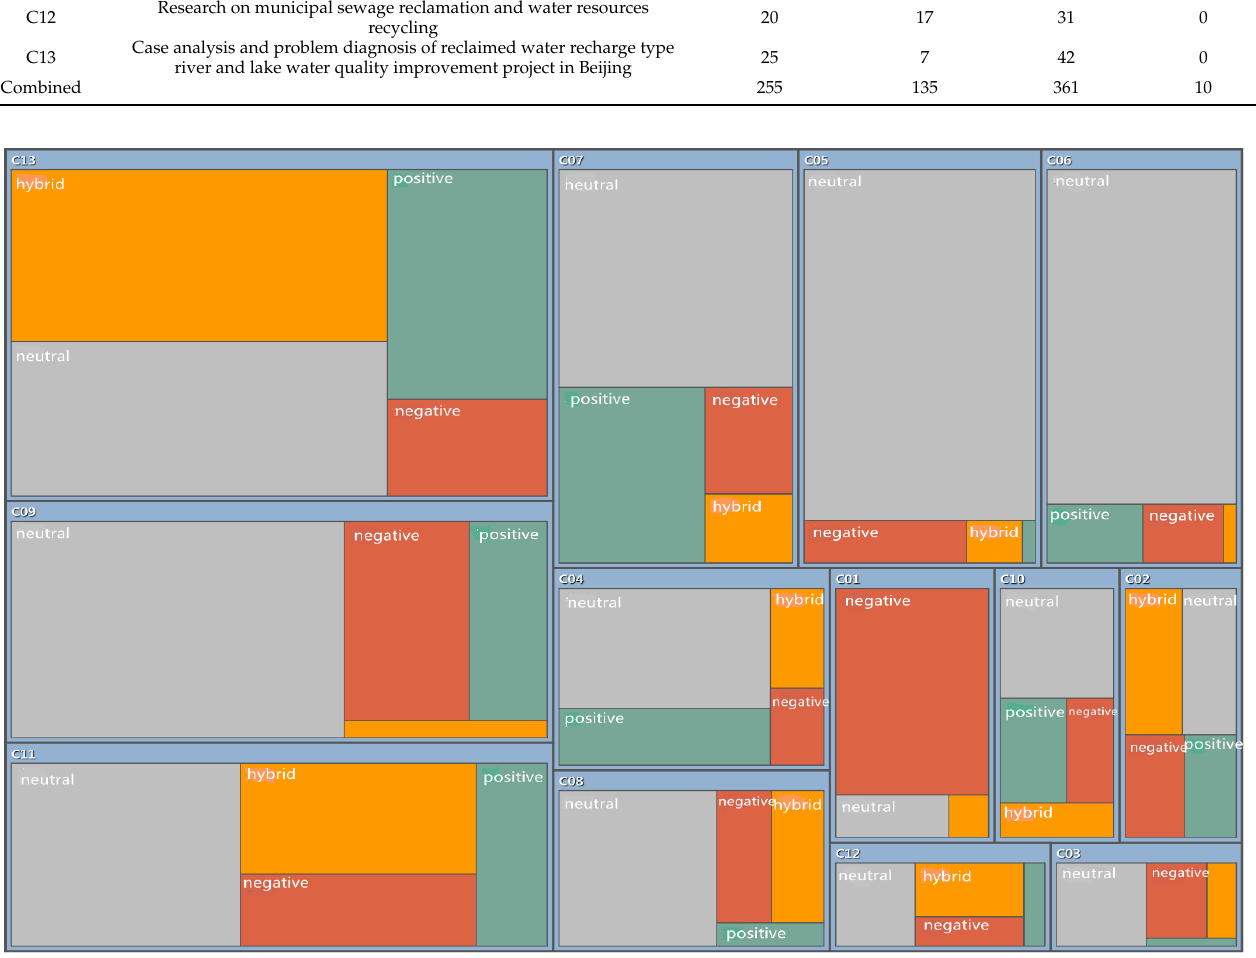
Figure 18. Hierarchical summary of automatically coded emotions toward highly cited literature in CNKI. Table 10. Summary of results of sentimental analysis of highly cited literature in CNKI.